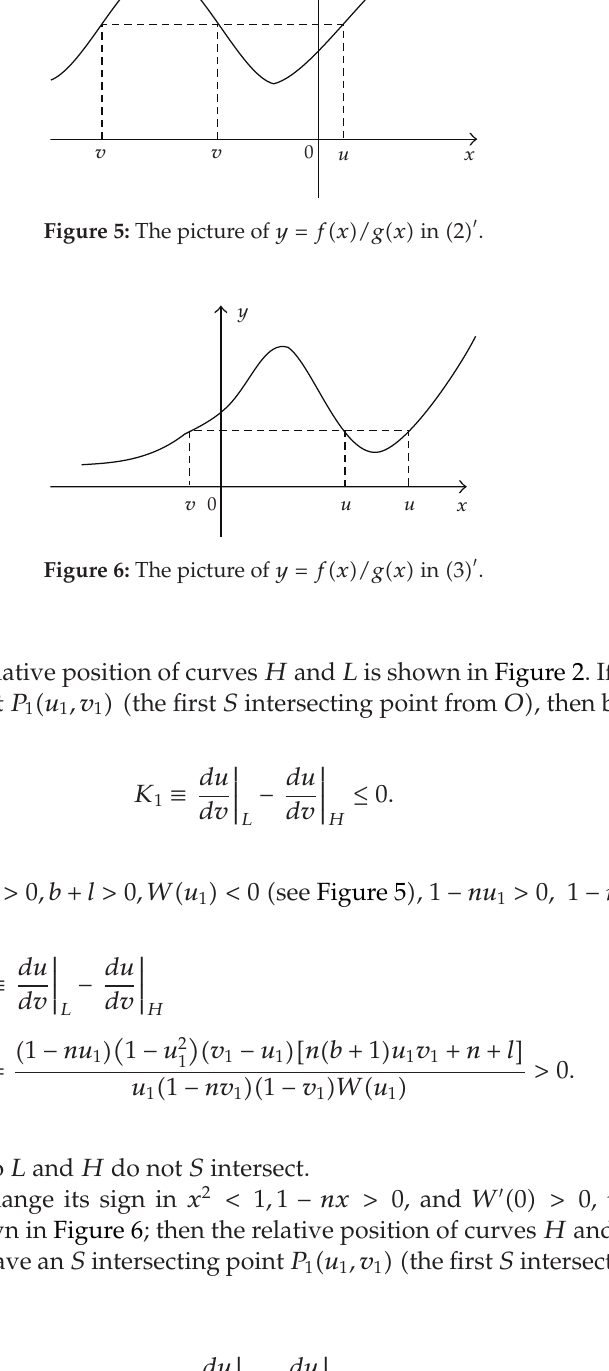
Figure 4. If H and L have an S intersecting point P 1 (cid:3) u 1 , v 1 (cid:4) (cid:3) the first S intersecting point